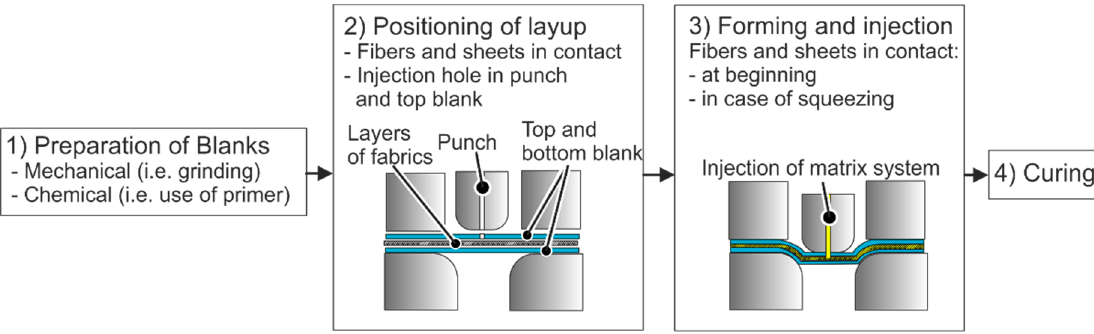
Figure 1. Process steps of the in situ hybridization process [12].